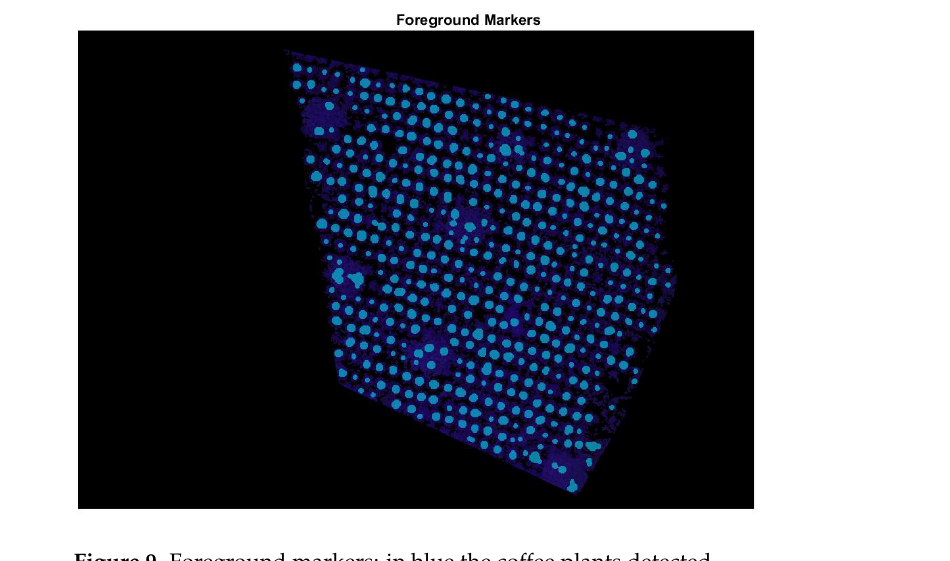
Figure 9. Foreground markers: in blue the coffee plants